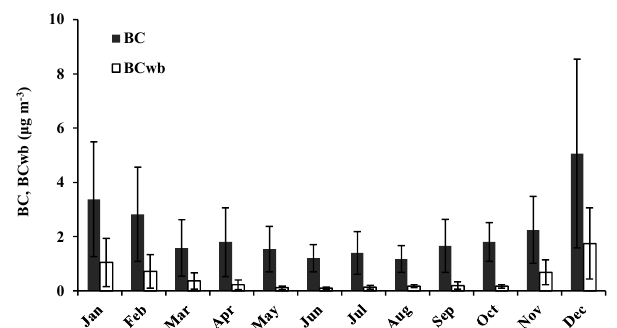
Figure 5. Seasonal variation of BC and BC wb at Thissio during May 2015–May 2016. The November point corresponds to black carbon measurements during the fall of 2016. Posterior data are used in order to depict a non-interrupted annual